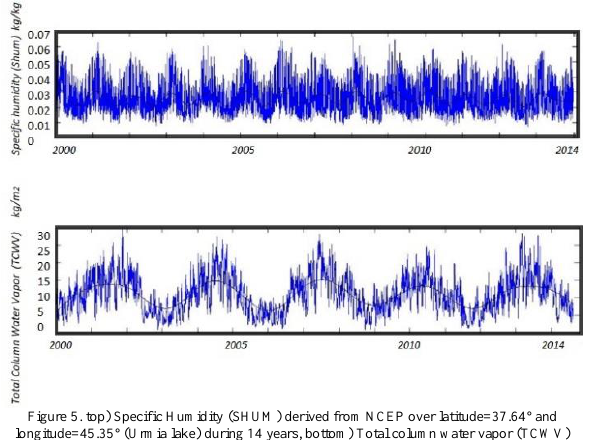
Figure 5. top) Specific Humidity (SHUM) derived from NCEP over latitude=37.64° and longitude=45.35° (Urmia lake) during 14 years, bottom) Total column water vapor (TCWV) derived from